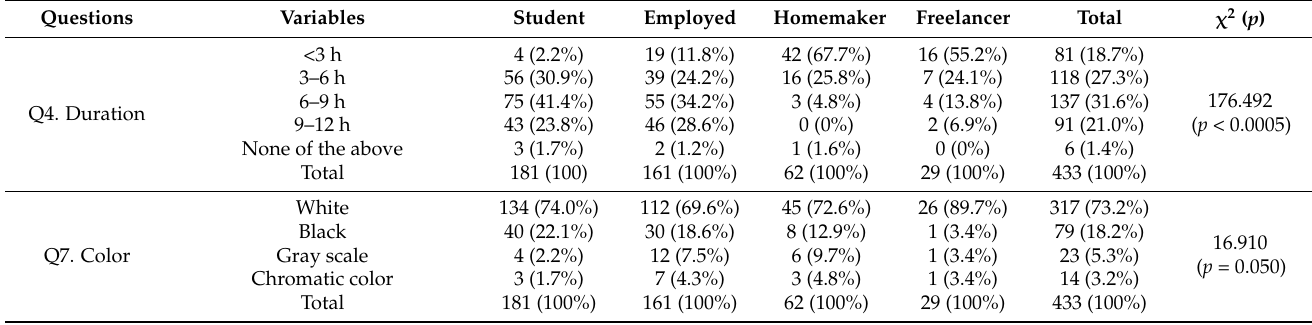
Table 7. Chi-squared test results according to